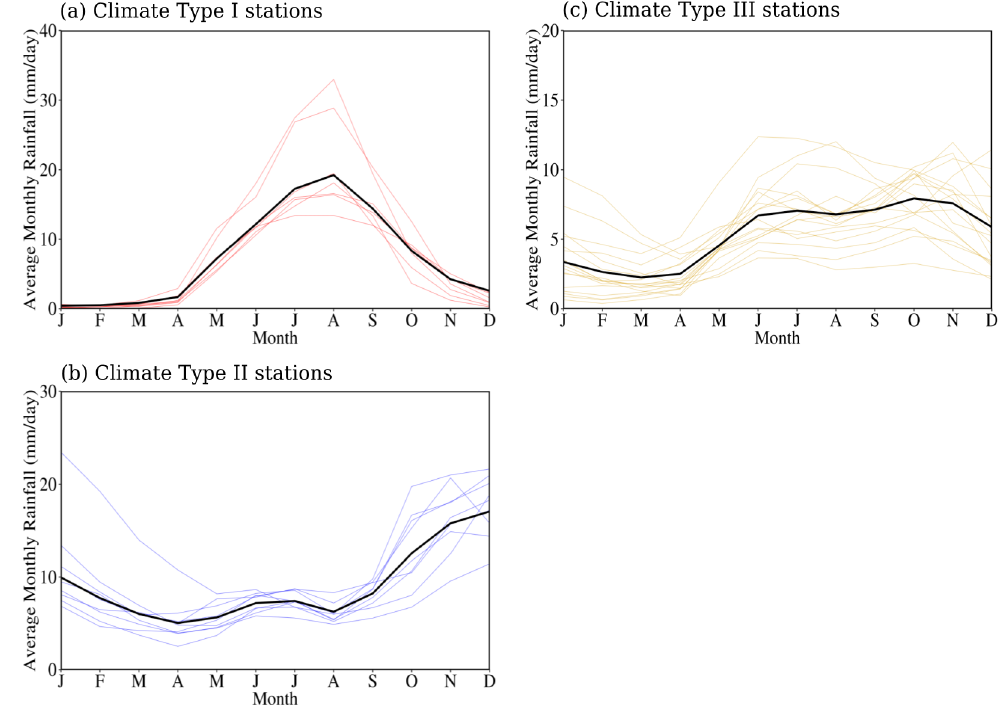
Figure 2. Average monthly rainfall (mm day − 1 ) distribution of the stations that belong to ( a ) Climate Type I; ( b ) Climate Type II; and ( c ) Climate Type III from the period 1961 to 2008. The black solid line